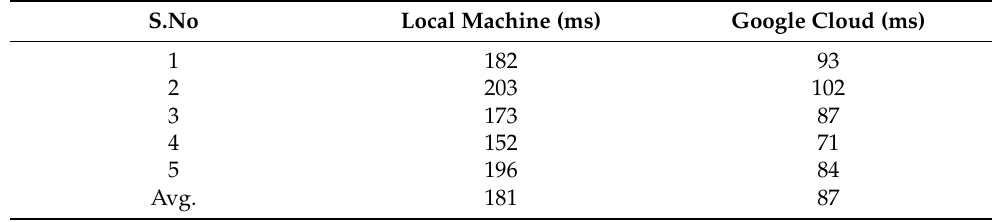
Table 3. Comparative study of time taken by the path planning algorithm using local machine and using Google cloud. S.No Local Machine (ms) Google Cloud (ms)